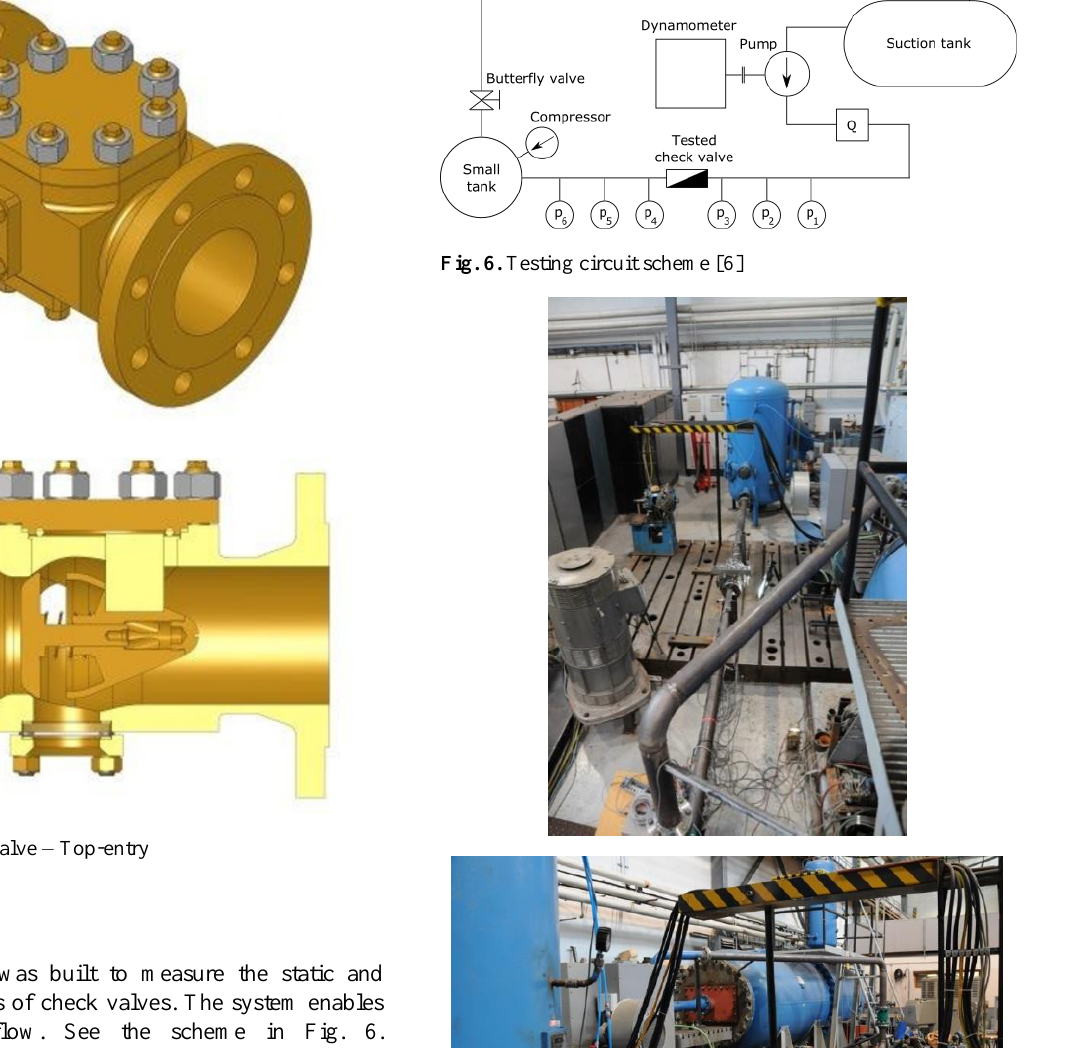
Fig. 6. Testing circuit scheme [6]